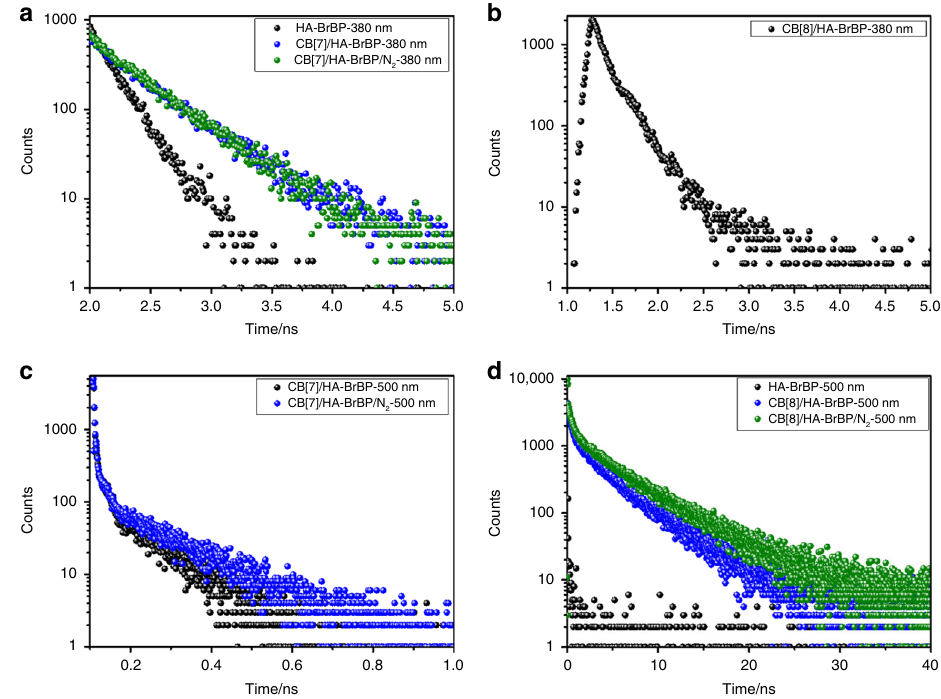
Fig. 4 Fluorescence and phosphorescence lifetime contrast curves for CB[7]/HA – BrBP and CB[8]/HA – BrBP. The fl uorescence decay curves of ( a ) HA – BrBP, CB[7]/HA – BrBP, CB[7]/HA – BrBP/N 2 and ( b ) CB[8]/HA – BrBP at 380 nm at 298 K; The phosphorescence decay curves of ( c ) CB[7]/ HA – BrBP, CB[7]/HA – BrBP/N 2 and ( d ) HA – BrBP, CB[8]/HA – BrBP, CB[8]/HA – BrBP/N 2 at 500 nm at 298 K. ([BrBP] = 0.5 mM, [CB[7]] = 0.5 mM, [CB[8]] = 0.25